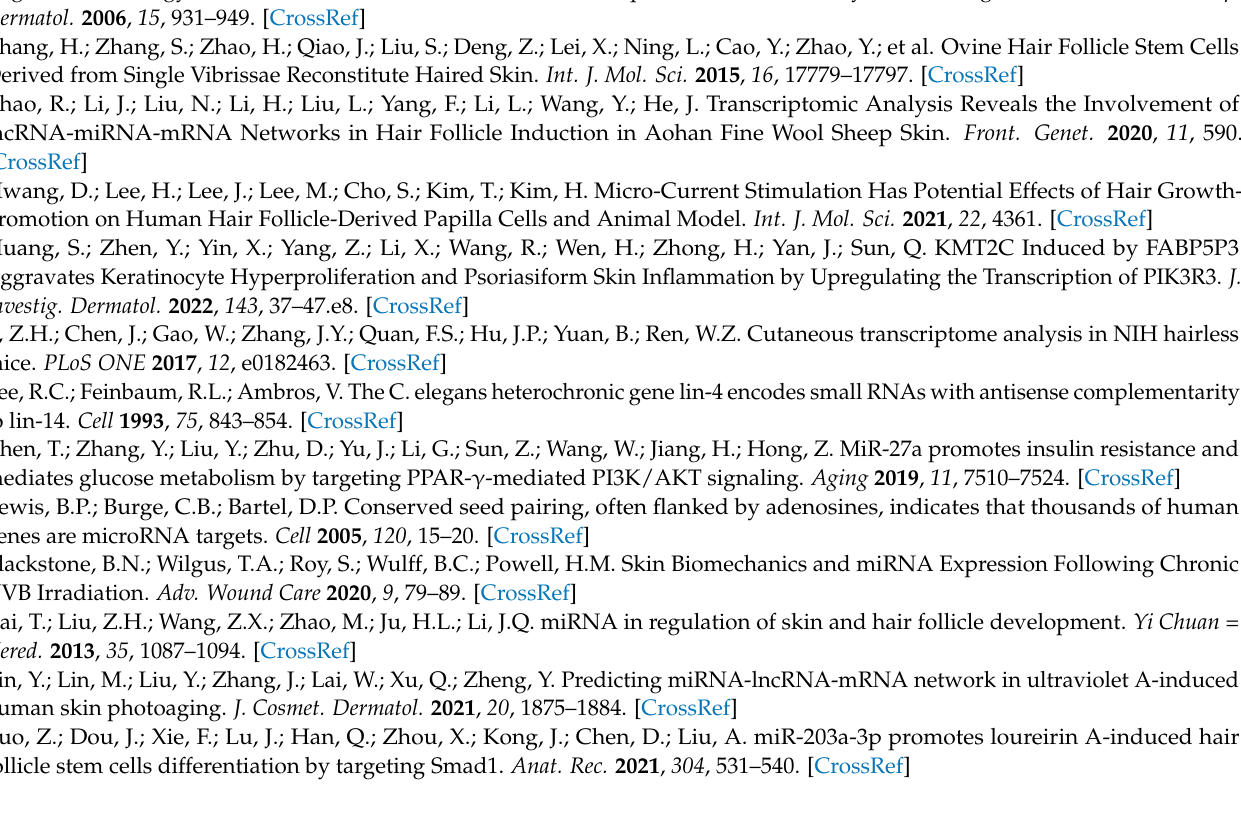
loading control. Figure S3: Changes of expression of PIK3R3 , AKT and MTOR and the levels of p-AKT and p-MTOR proteins upon expression of a miR-27a inhibitor or a negative control (NC) in HFSCs, with GAPDH serving as a loading